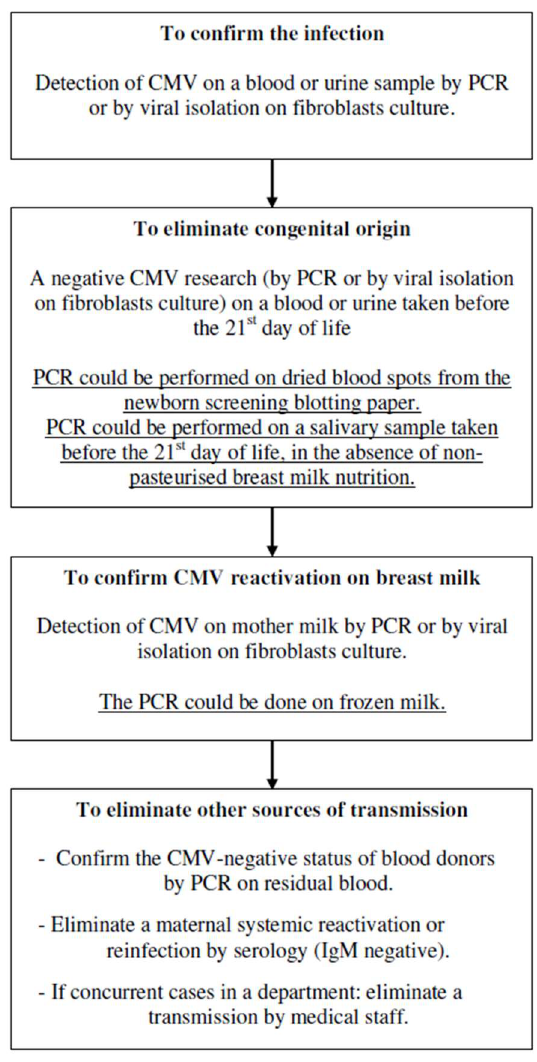
Figure 3. Possible exhaustive diagnostic approach of milk-acquired CMV infections. PCR: polymerase chain reaction.